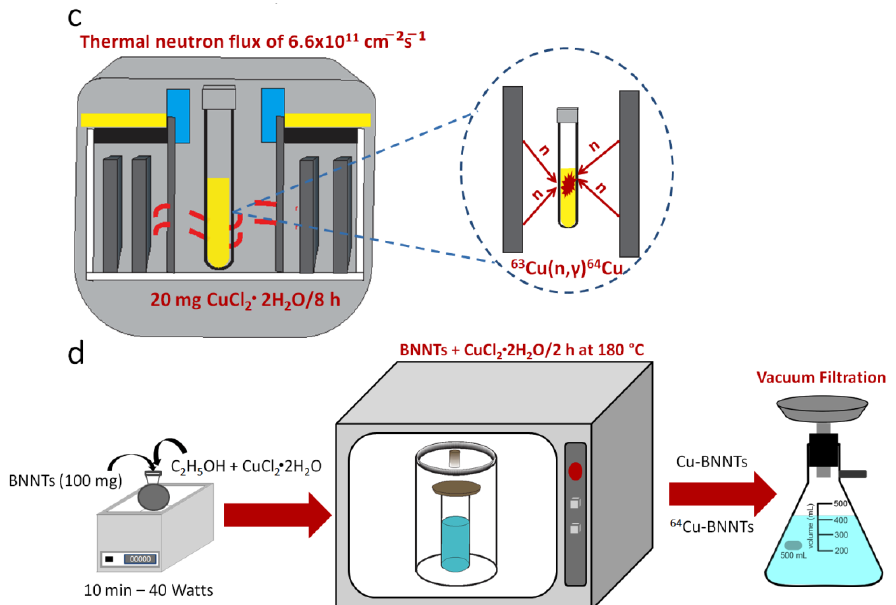
Figure 1. Schematic representation of synthesis of the BNNTS ( a ), purification process ( b ), activation process of CuCl 2 · 2H 2 O to obtainment of 64 Cu radioisotope ( c ) and incorporation of Cu and 64 Cu into BNNTs samples ( d ).